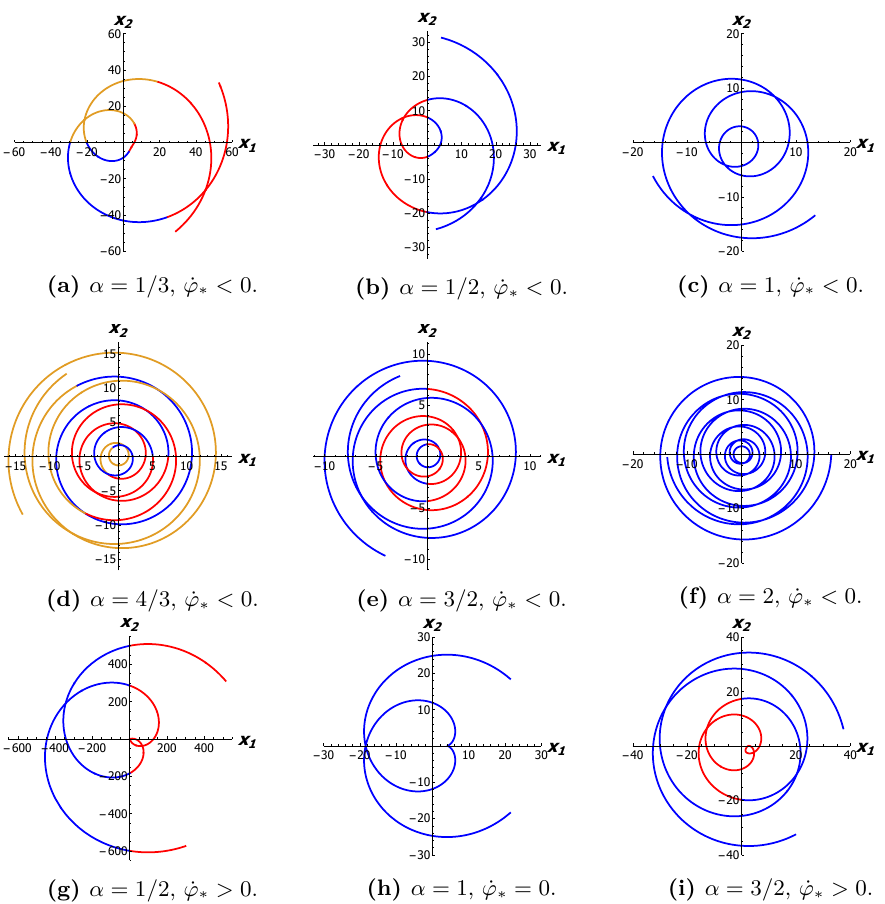
Figure 1. Trajectories for different rational values of the cone parameter α and Ω > 0 . The colour change in the trajectories indicates the transition from one Riemann surface sheet to another. In figures 1a and 1d (1b, 1e, 1g and 1i) the corresponding Riemann surface has three (two) sheets, while in figures 1c and 1f the Riemann surface is the complex plane itself.